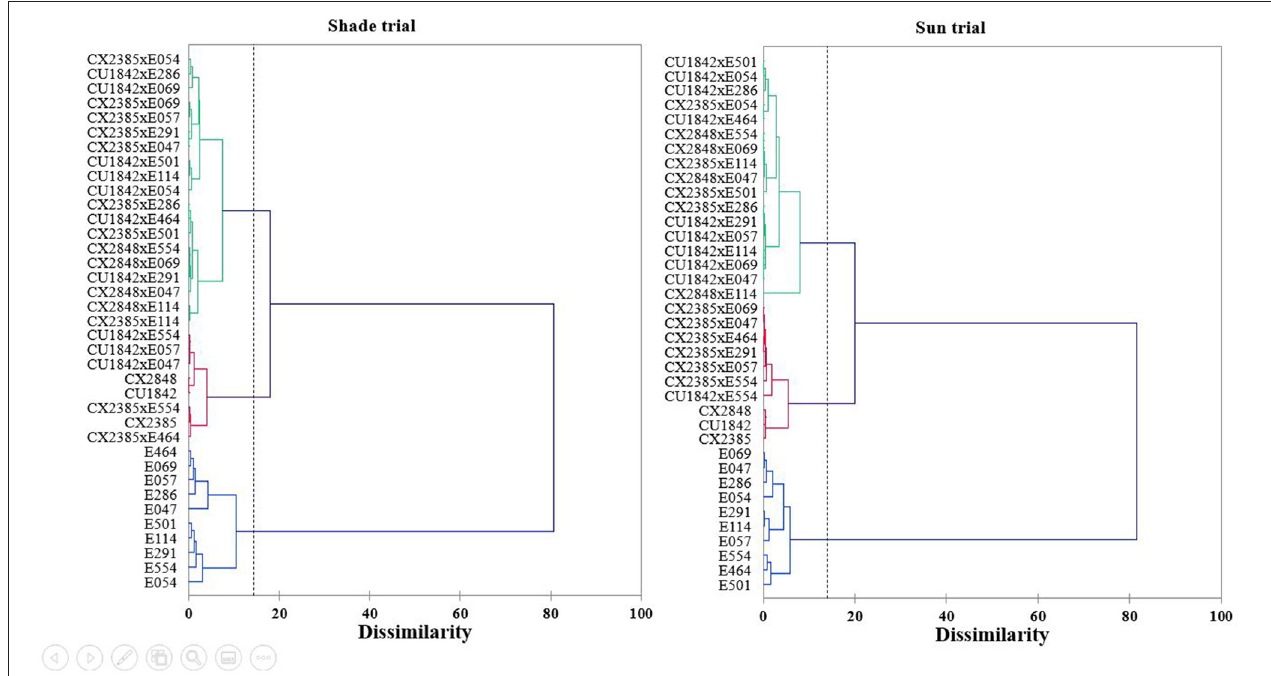
FIGURE 4 | Hierarchical cluster analysis (Euclidean distance, Ward’s grouping method) resulting from the discriminant analysis of the 38 varieties studied based on yield, bean size, tree volume and NIRS signature, under shade and in full sun conditions. The upper graph corresponds to shade conditions and the lower graph to full-sun